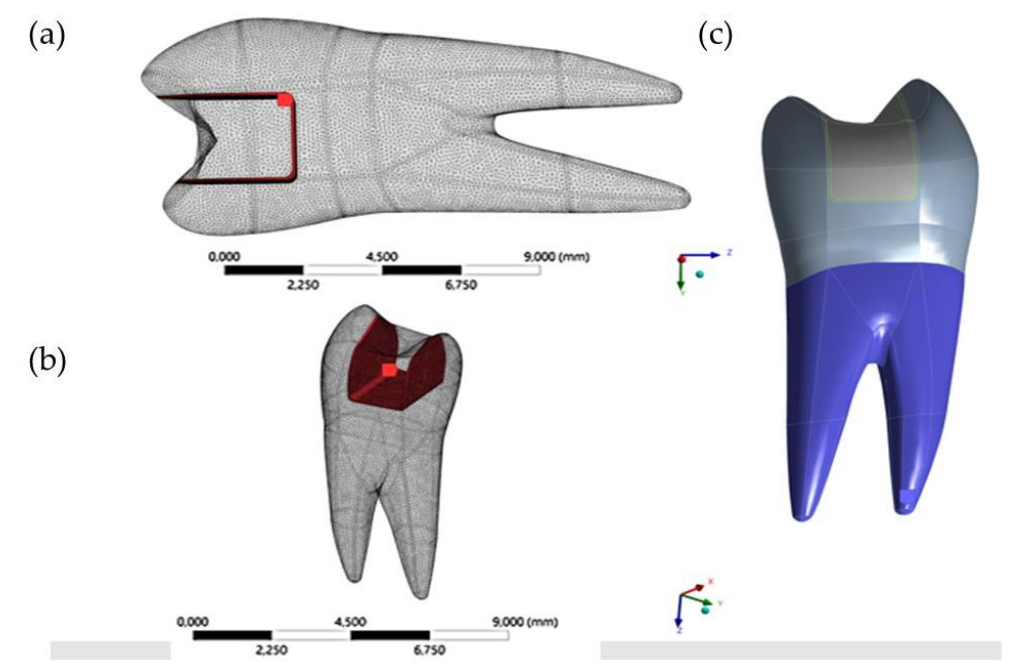
Figure 2. Finite element model showing: ( a ) cement layer mesh with perfectly bonded contact with the walls; ( b ) fixed support applied in the roots; ( c ) mesh generation in perspective view with the composite resin polymerization shrinkage.